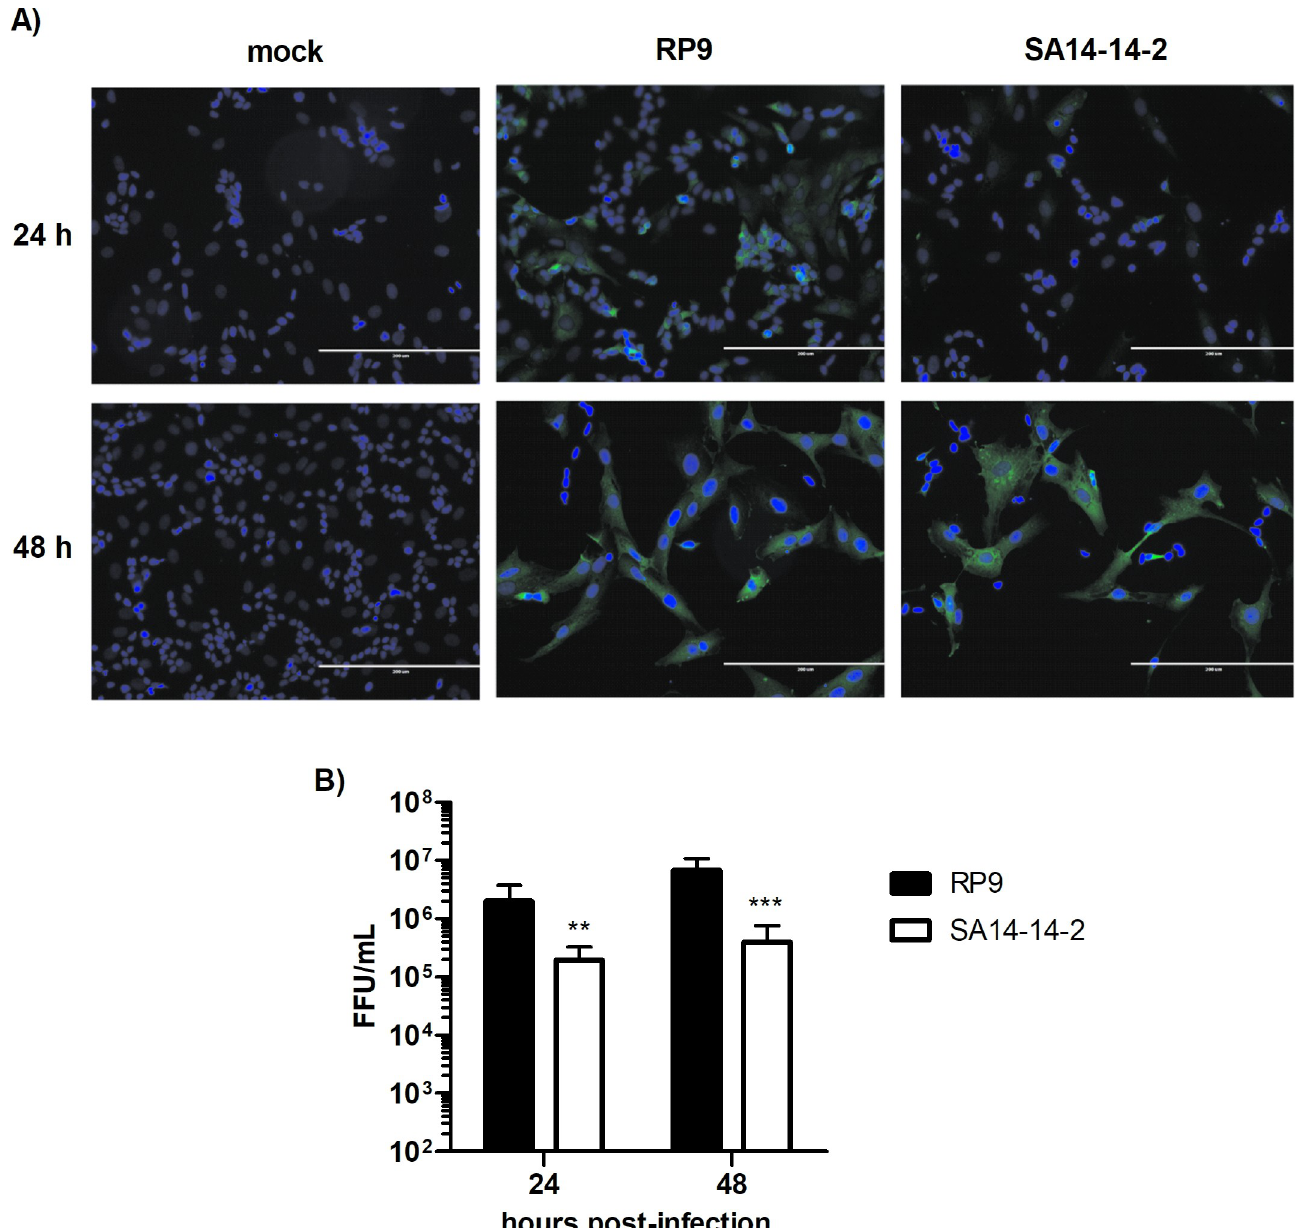
Fig 2. JEV RP9 is more replication efficient than JEV SA14-14-2 in SK-N-SH cells. SK-N-SH cells were infected at MOI 0.1 for 24 or 48h by the indicated JEV strain. A) The infected cells were analyzed at the indicated times post-infection by immunofluorescence staining for the presence of the NS5 protein (in green). The images were taken at a x200 magnification (white bars, 100 μ m), the cell nuclei were stained by DAPI (in blue). B) Supernatants of SK-N-SH cells infected by JEV RP9 (black bar) or JEV SA14-14-2 (white bar) were titrated in Vero cells. The arithmetic means ± standard deviation of three independent experiments performed in triplicate is shown. Asterisks indicate a significant difference between RP9 and SA14-14-2 in each one of the times post-infection evaluated ( �� , P = 0.0023, ��� , P < 0.001). https://doi.org/10.1371/journal.pone.0252595.g002 PLOS ONE | https://doi.org/10.1371/journal.pone.0252595 June 4,